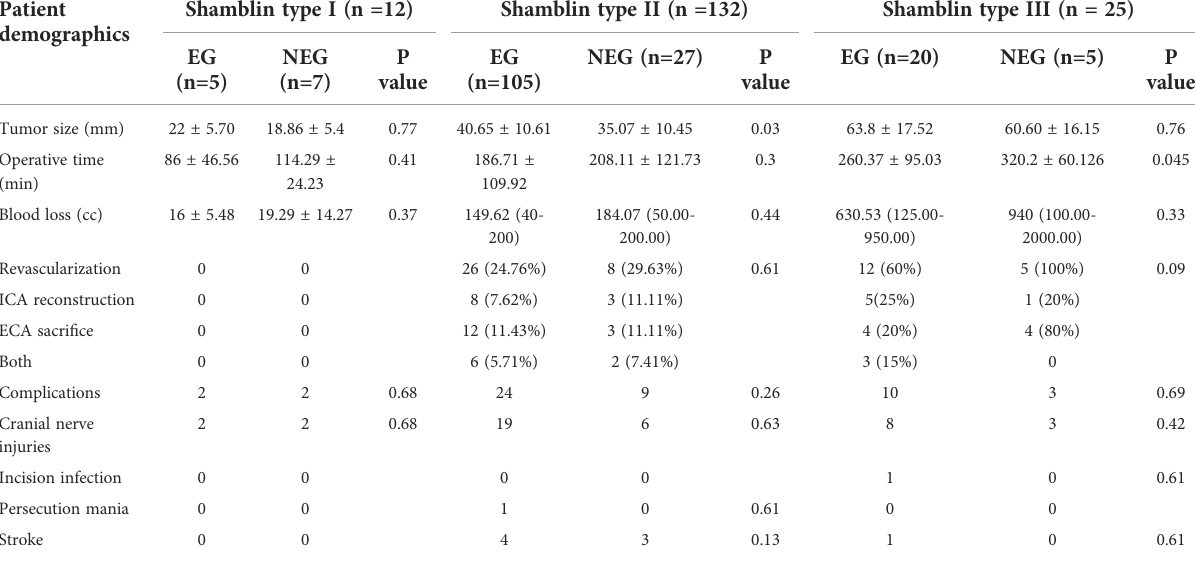
TABLE 3 Differences between the embolization group and non-embolization group according to Shamblin classi fi cation. Patient